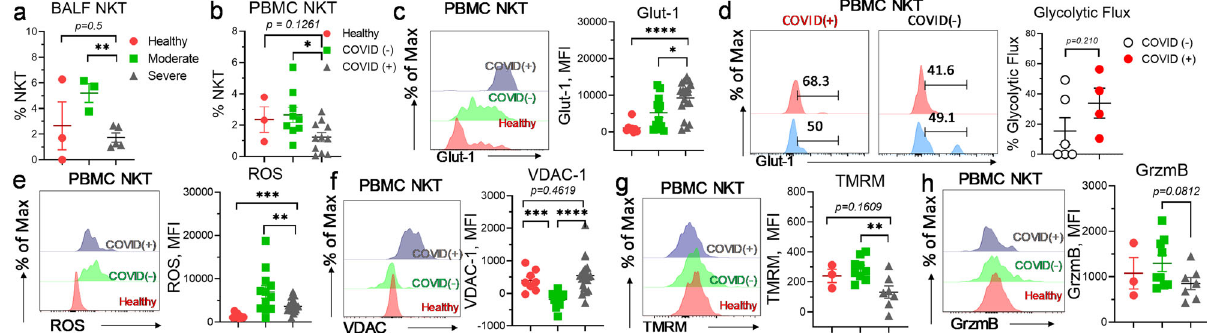
Fig. 9 Circulating NKTs exhibit dysfunctional immunometabolic phenotype in COVID-19. a Summary graph demonstrating the frequency of NKT in PBMCs from healthy, COVID( − ), and COVID( + ) patients ( n = 3 HD, 3 M, 4 S). b Summary graph demonstrating the frequency of NKT in the BALF from healthy, moderate, and severe patients ( n = 3 HD, 9 C − , 11 C + ). c Summary graphs and histograms demonstrating the expression of glut-1 in NKTs from healthy, COVID( − ), and COVID( + ) patients ( n = 8 HD, 12 C − , 20 C + ). d Histograms and graphs demonstrating glycolytic fl ux of NKTs from COVID( − ) and COVID( + ) patients from the SCENITH assay ( n = 6 C − , 4 C + ). e – h Histograms and graphs demonstrating the expression of ROS ( n = 8 HD, 12 C − , 20 C + ) ( e ), VDAC ( n = 8 HD, 12 C − , 20 C + ) ( f ) TMRM ( n = 3 HD, 9 C − , 7 C + ) ( g ), and grzmB TMRM ( n = 3 HD, 9 C − , 7 C + ) ( h ) in NKTs from healthy, COVID( − ), and COVID( + ) patients. d , f , g , h Four samples were removed from analysis due to a critically low NKT cell count. Two-tailed student ’ s t test was used. * p < 0.05, ** p < 0.01, and *** p < increase in the glycolytic fl ux of COVID( + ) NKTs (Fig. 9d).